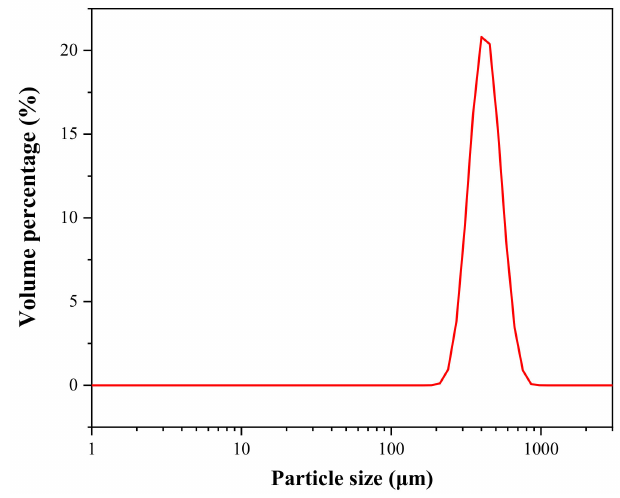
Figure 10. Particle size distribution of the quartz